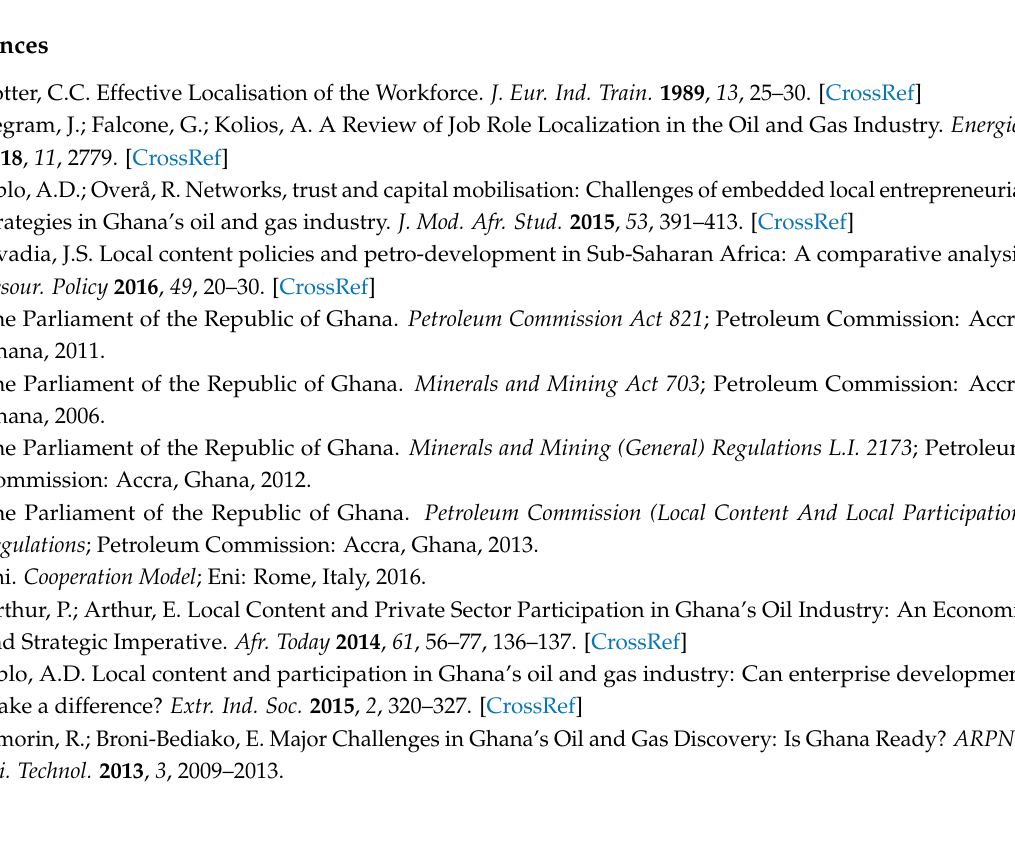
s1, Table S1: Questionnaire, Table S2: Questions that showed no statistically significant differences in responses based on organization